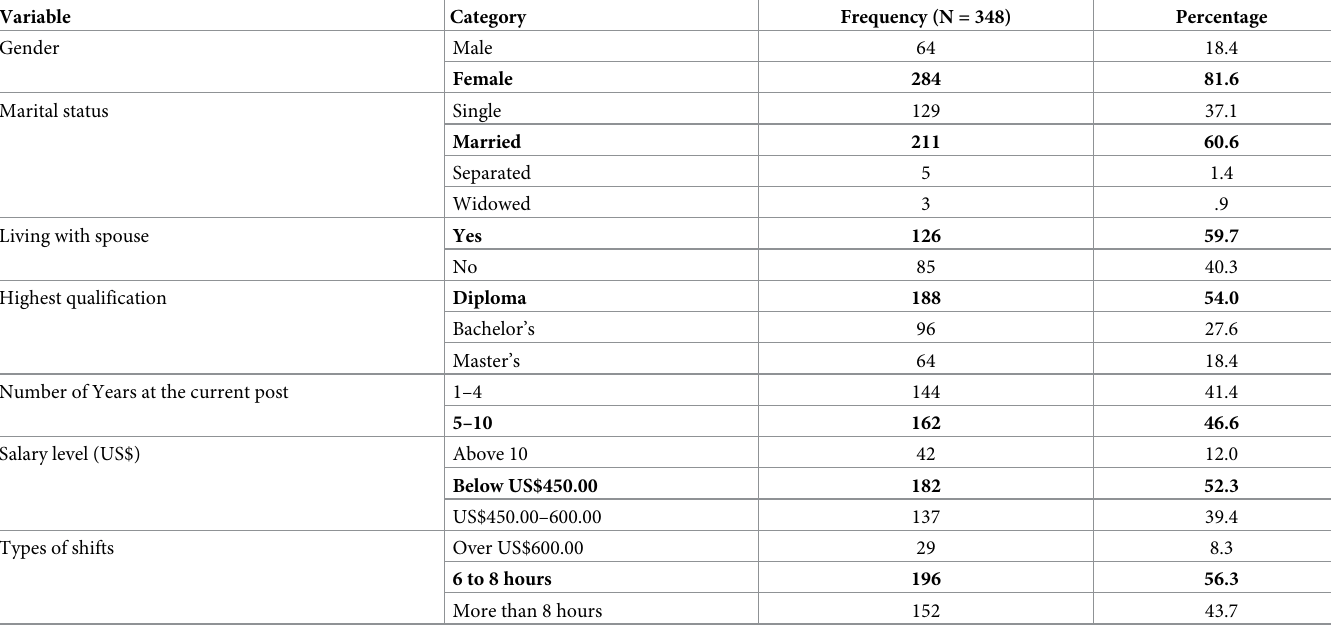
Table 1. Sociodemographic and job characteristics of participants in the